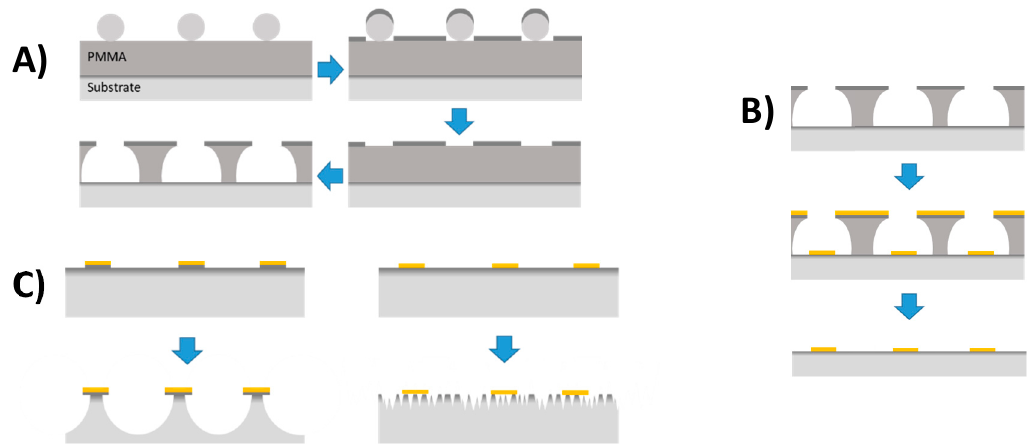
Figure 1. Schematic representation of nanodisk fabrication using hole-mask colloidal lithography. ( A ) Polystyrene particles self-assembles onto PMMA coated ITO substrates, followed by titanium mask deposition, tape stripping, and plasma etching. ( B ) Gold is evaporated through the mask at normal angles either directly onto the substrate (illustrated here), or following deposition of a 2-nm titanium adhesion layer. Subsequent mask removal leaves arrays of gold nanodisks on substrate. ( C ) Under-etching of substrate for gold nanodisks immobilized on ITO with (left) or without (right) an intermediate titanium adhesion layer.